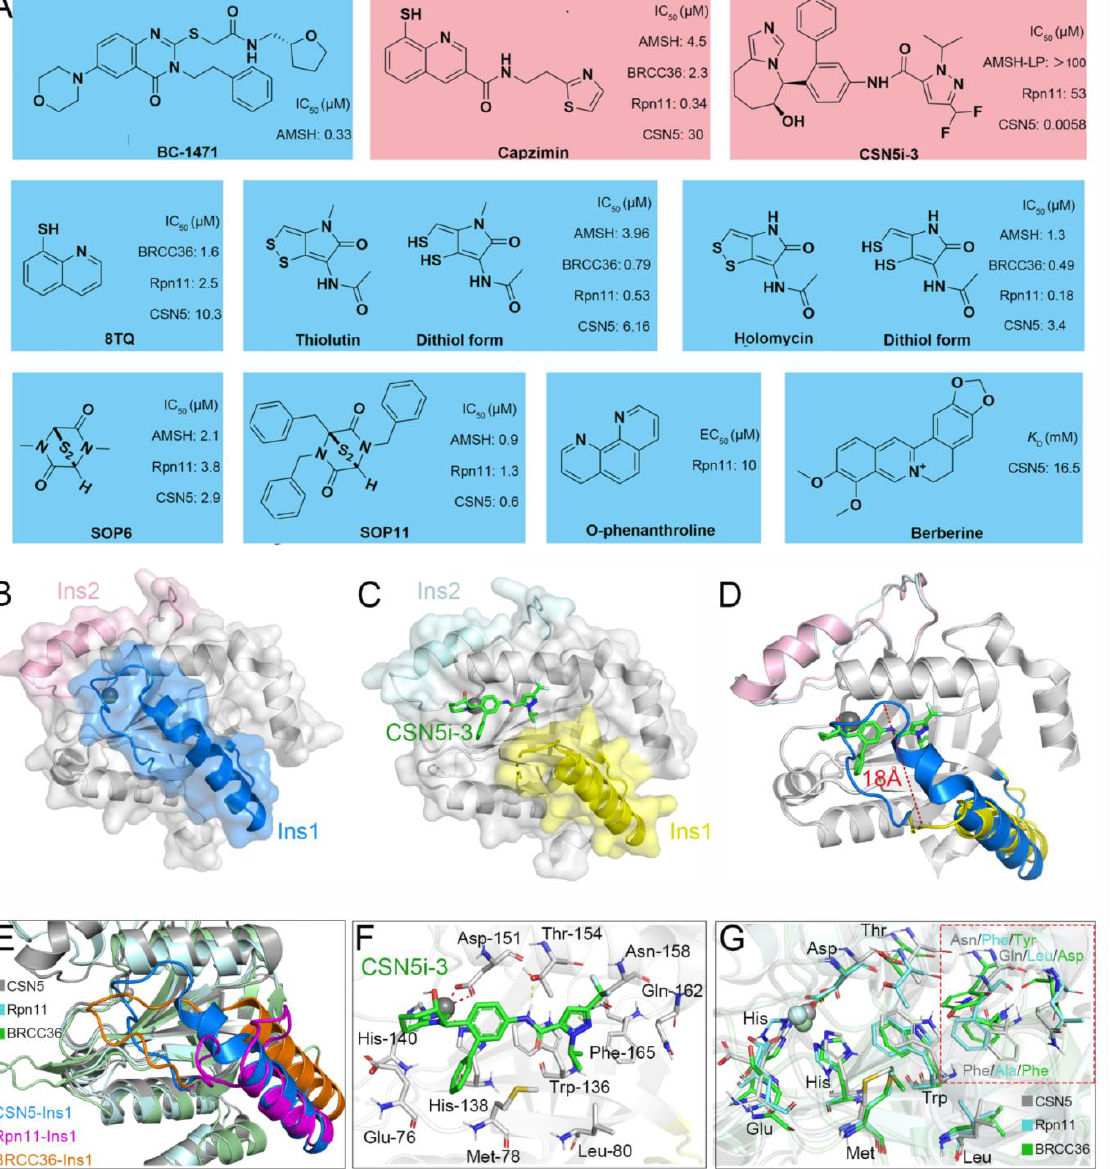
8-thioquinoline (8TQ) (IC 50 = 2.5 µ M) by screening a library of metal-binding